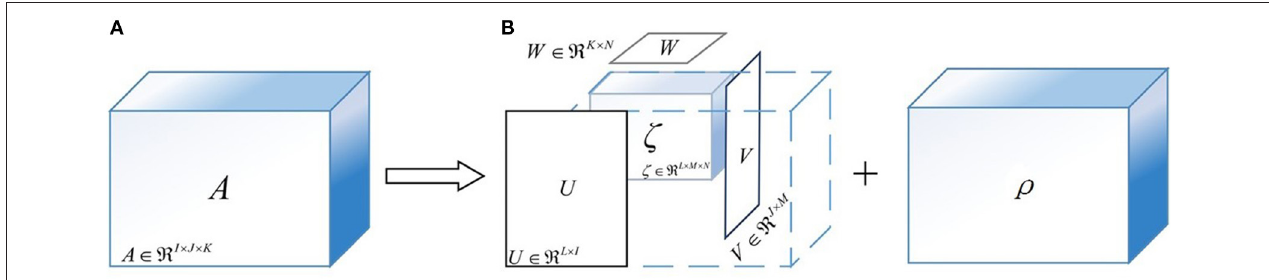
FIGURE 7 | The sketch maps of Tucker decomposition for a three-way tensor. (A) The original feature tensor A. (B) The result of Tucker decomposition algorithm. (Note) U , V , and W are the factor matrices; ζ is the core tensor; ρ is the approximation error.